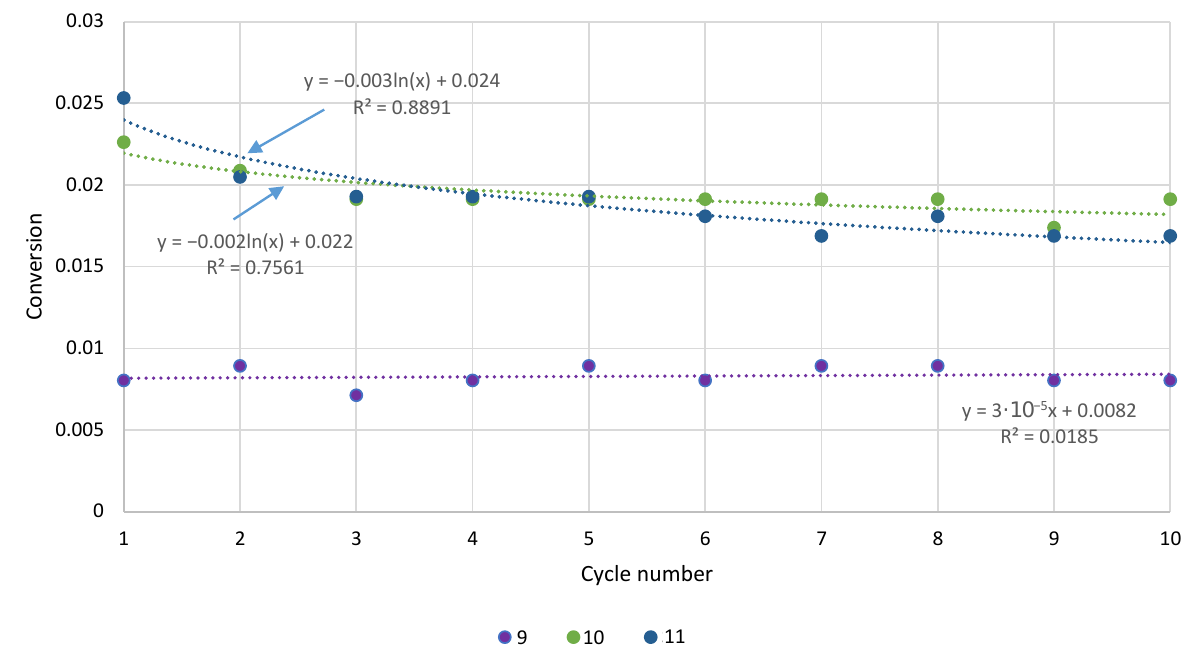
Figure 16. The conversion of carbonate rocks in the CaL process.